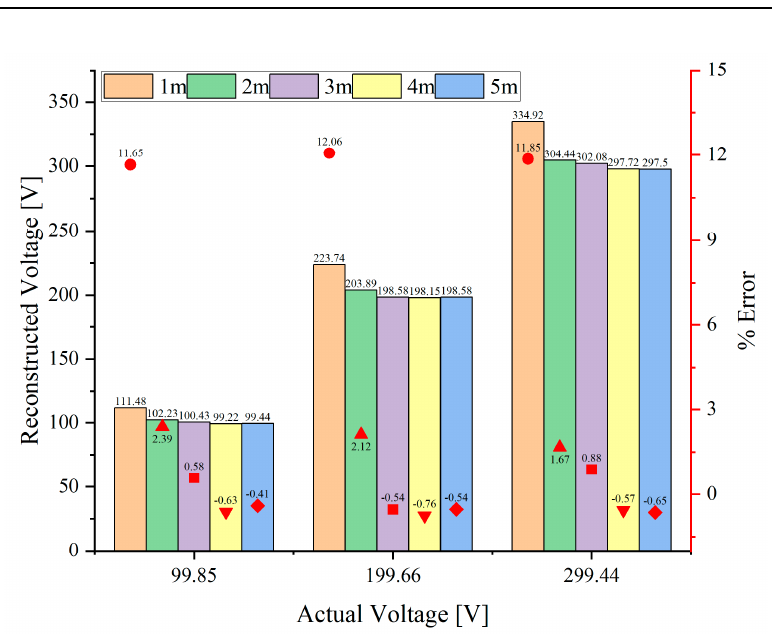
Figure 16. Experimental comparison chart for different heights.